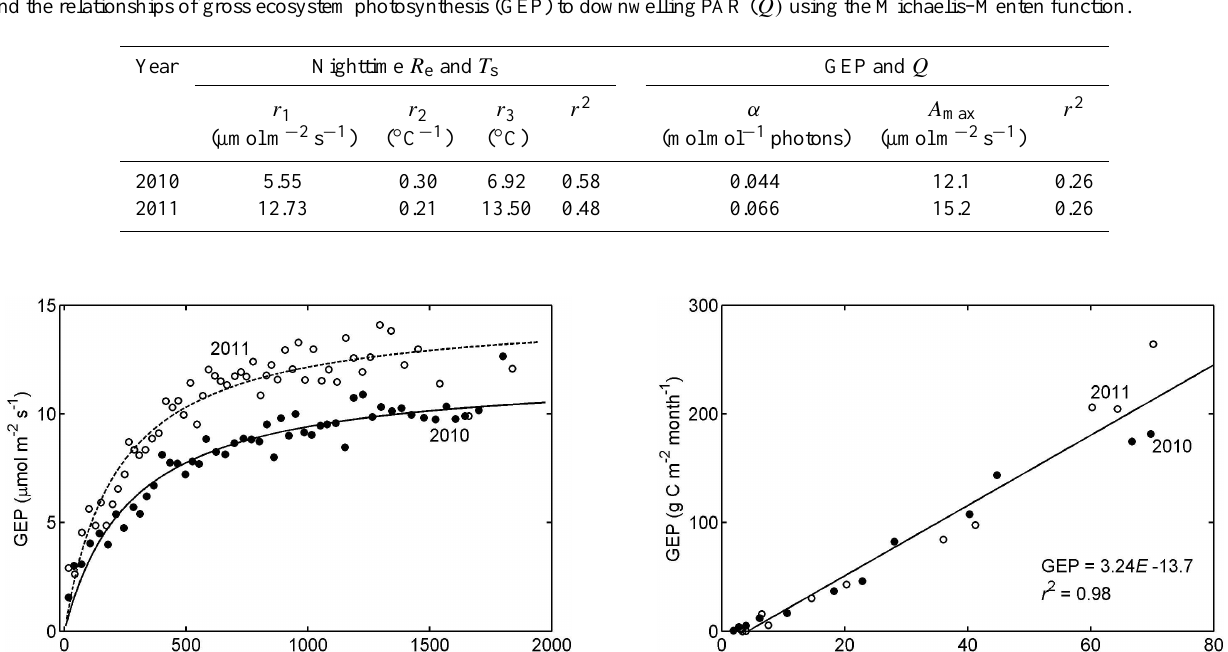
Table 4. Parameters for the relationships of nighttime respiration ( R e ) to soil temperature at the 3cm depth ( T s ) using the logistic equation, and the relationships of gross ecosystem photosynthesis (GEP) to downwelling PAR ( Q) using the Michaelis–Menten function.